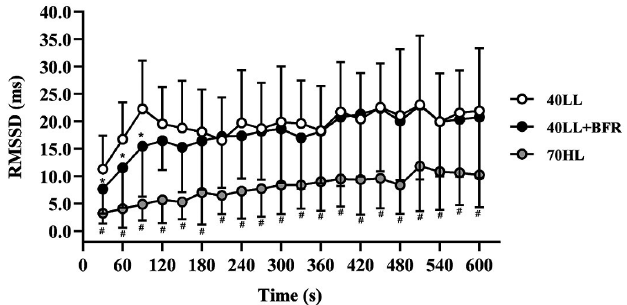
Figure 2. Mean and SD of root-mean-square of successive differences in the RR intervals measured in successive 30s segments (RMSSD30s) during the 10 min recovery period after the constant load exercise for each experimental condition.